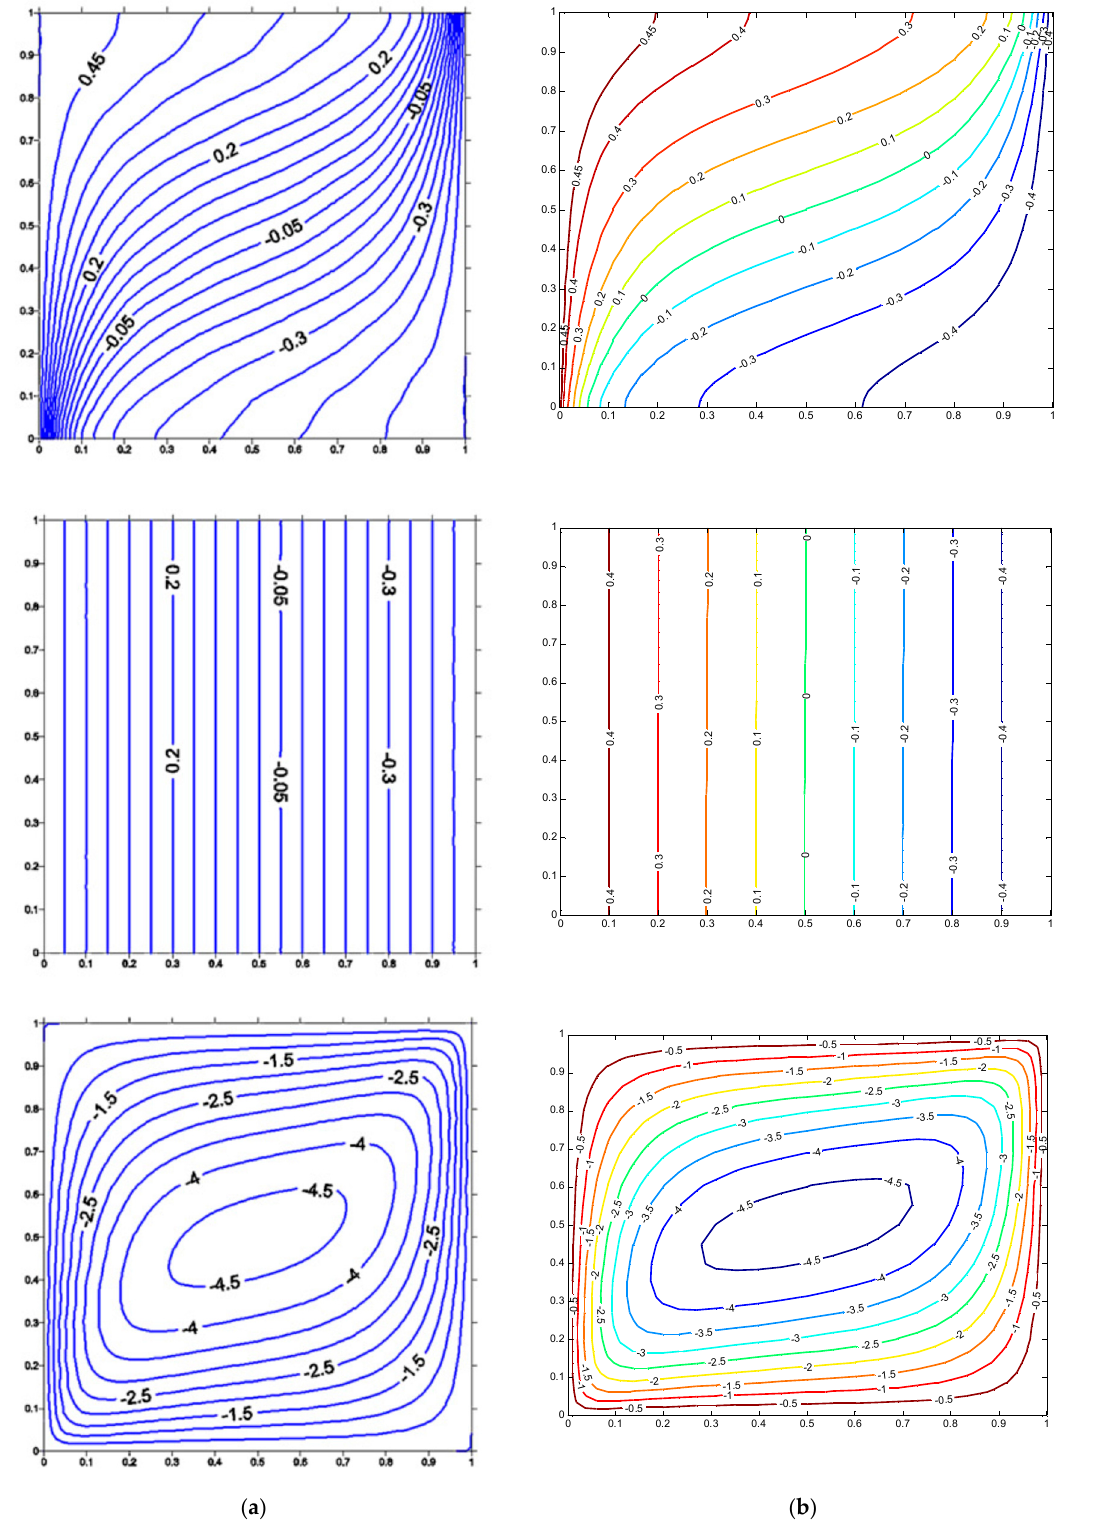
Figure 4. Isotherms for fluid (Top), solid (Middle), and streamlines (Bottom) at Ra = 100 , R d = 0.5 , Kr = 1 , H = 0 . 1, ( a ) Ref [27]. ( b ) Present.